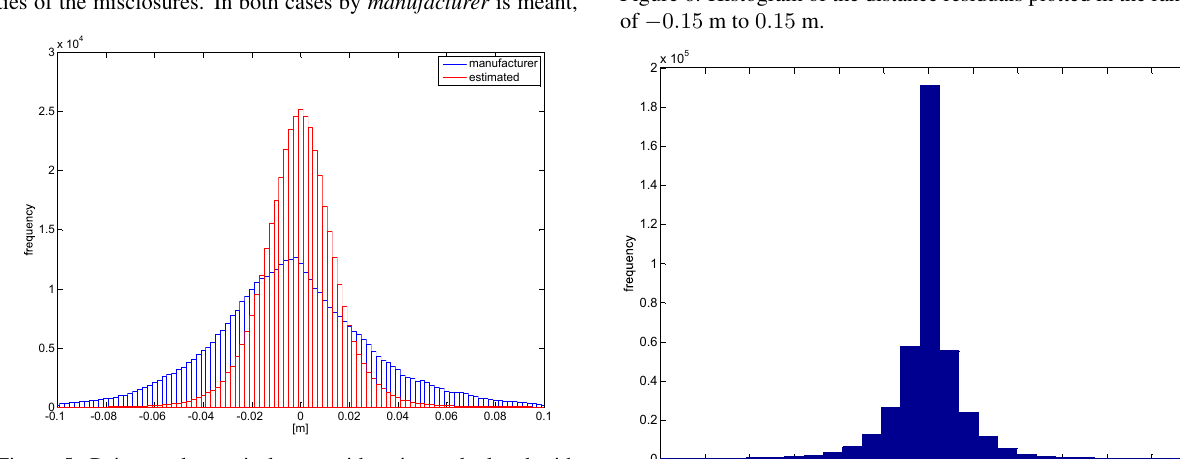
Figure 5: Point-to-plane misclosure with points calculated with manufacturer calibration procedure and values and calculated with (3) and estimated values plotted in the range of − 0 . 11 m to 0.11 m.